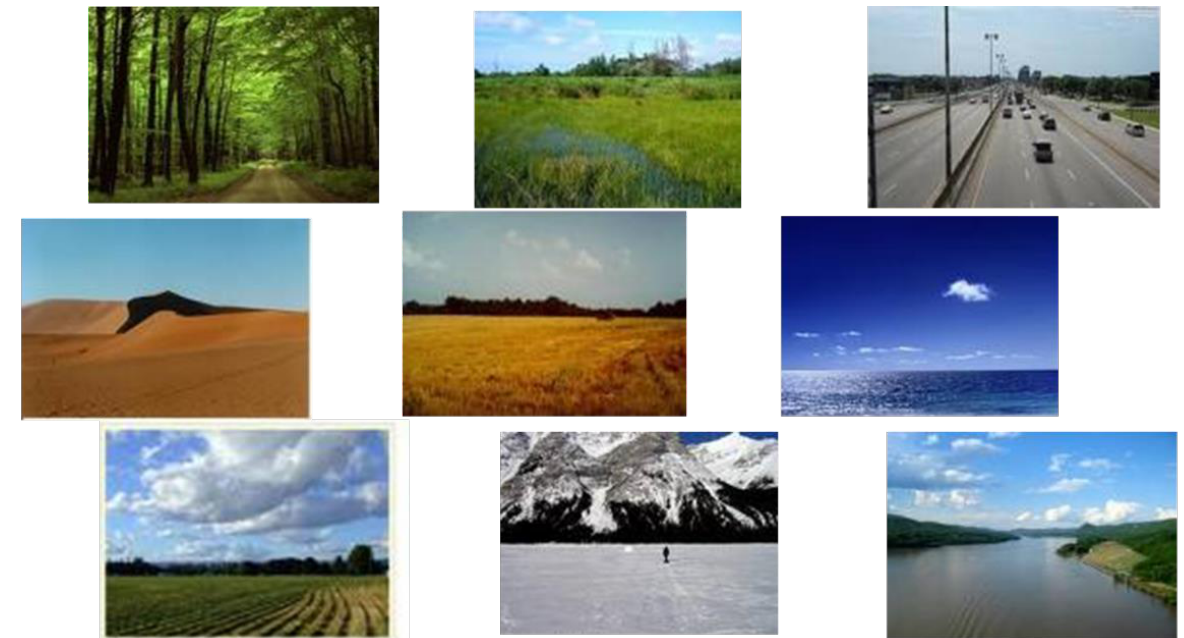
Figure 1. Landing sites for off-field